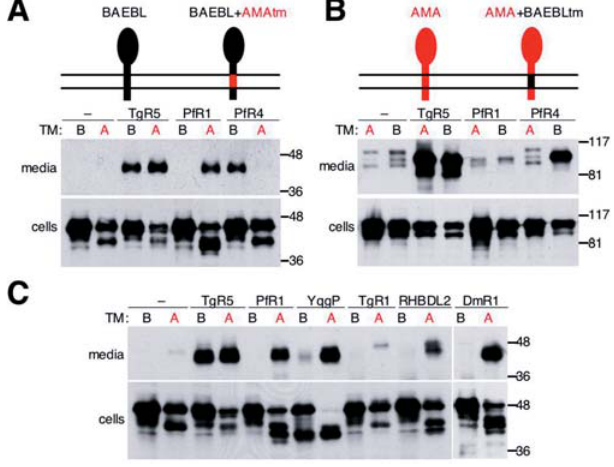
Figure 6. Specificity of PfROMs 1 and 4 for the Transmembrane Domains of AMA1 versus that of BAEBL (A) Cleavage of GFP-tagged BAEBL (drawn in black) and GFP-tagged BAEBL harboring the transmembrane domain of AMA1 (in red) were tested for cleavage by anti-GFP Western analysis of media from transiently transfected COS cells. While TgROM5 could cleave both proteins efficiently, PfROM1 could only cleave BAEBL þ AMAtm, while PfROM4 could only cleave BAEBL. (B) Cleavage of GFP-tagged AMA1 (drawn in red) and GFP-tagged AMA1 harboring the transmembrane domain of BAEBL (in black) were tested for cleavage by anti-GFP Western analysis of media from transiently transfected COS cells. While TgROM5 could cleave both proteins efficiently, PfROM1 could only cleave AMA1 while PfROM4 could only cleave AMA þ BAEBLtm. (C) Other rhomboid enzymes including YqgP (from Bacillus subtilis ) and RHBDL2 (from Homo sapiens ) also cleaved BAEBL more efficiently when it contained the transmembrane domain from AMA1, like PfROM1 but not PfROM4. Molecular weight standards in kDa are denoted to the right of each panel. DOI: